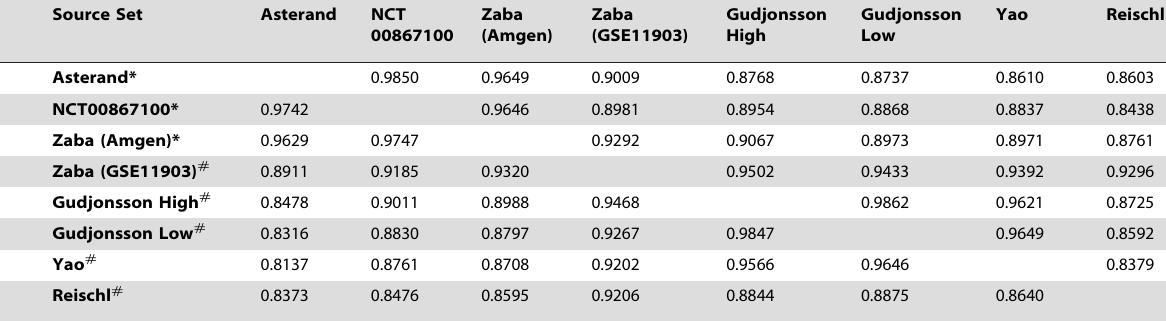
B Comparison using cut-offs of p-value # 0.05 in source